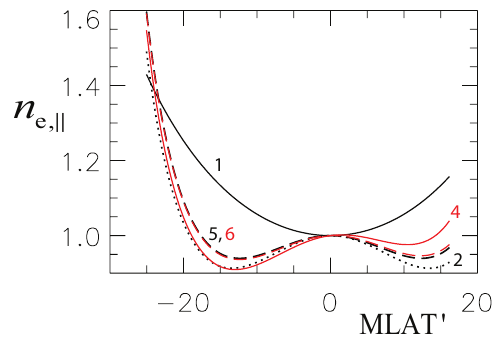
Fig. 10. Parallel dependence of n e , n e , k , versus the magnetic lat- itude MLAT 0 for fits with n e , k symmetric with respect to MLAT 0 (black curves): fit 1 (solid black curve), fit 2 (dotted black curve), and fit 5 (dashed black curve); and for asymmetric (with respect to MLAT 0 ) dependencies (red curves): fit 4 (solid red curve), and fit 6 (dashed red curve).